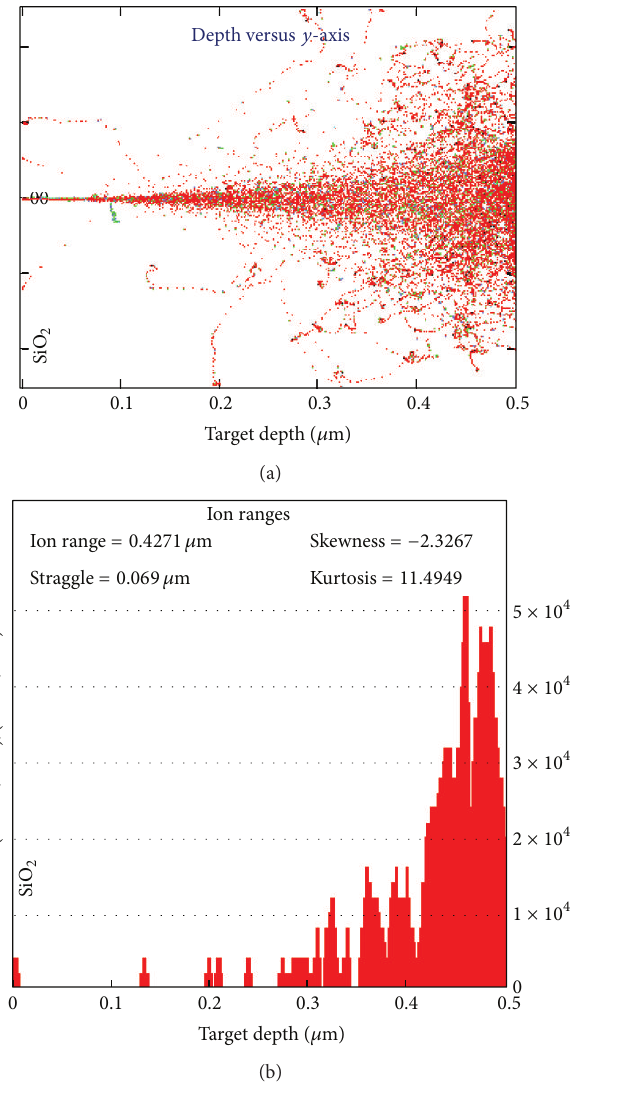
Figure 3: The simulation of 50keV protons passing through 0.5 𝜇 m thick layer of SiO 2 (500 events). (a) Trajectory of protons in 𝑥𝑂𝑦 plane. (b) Distribution of stopped protons along the oxide depth.